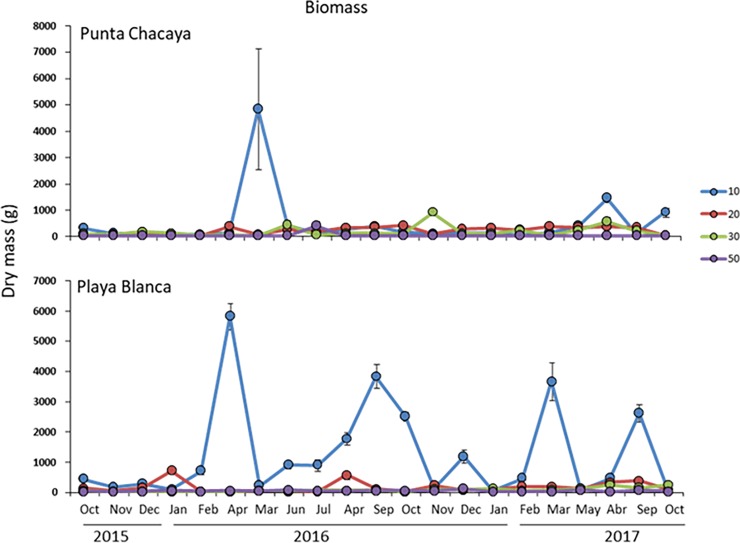
Variability in biomass.Temporal fluctuations in biomass (mean ± SD) of the macrobenthos per sampling site during the study period in Mejillones Bay. Color lines represent depth in m.